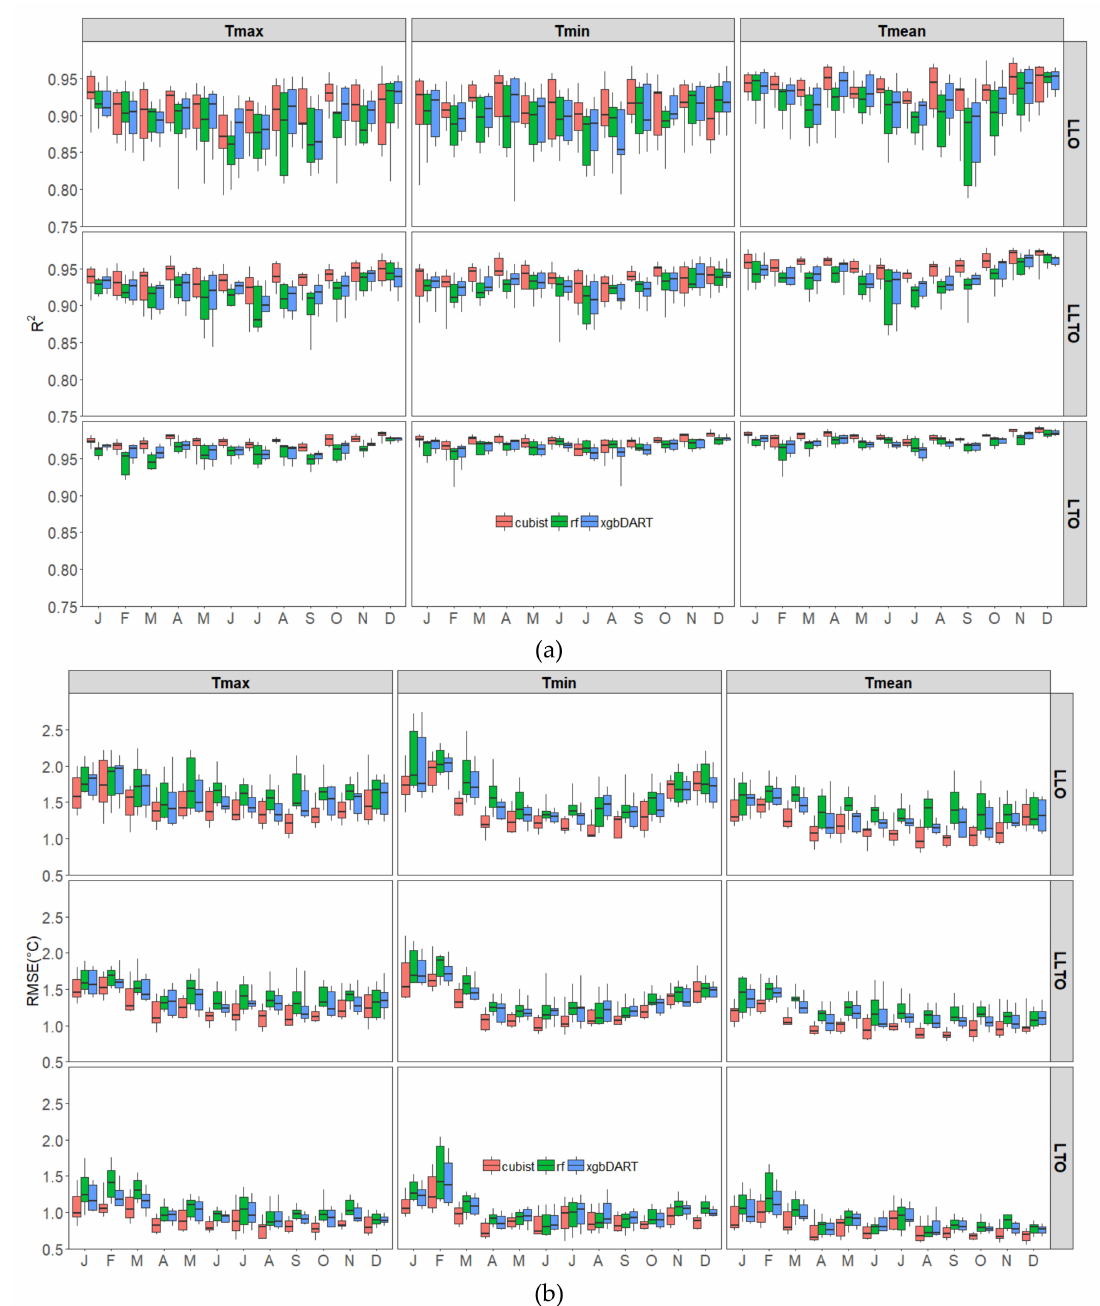
Figure 5. ( a ) and ( b ) show the R 2 and RMSE for maximum (Tmax), minimum (Tmin) and mean (Tmean) air temperatures using rf, cubist and xgbDART methods based on LLTO-CV, LTO-CV, LLO-CV. The boundaries of box mark the 25th and 75th percentiles; the horizontal black lines within the box indicate the median; the upper and lower whiskers mark the 90th and 10th